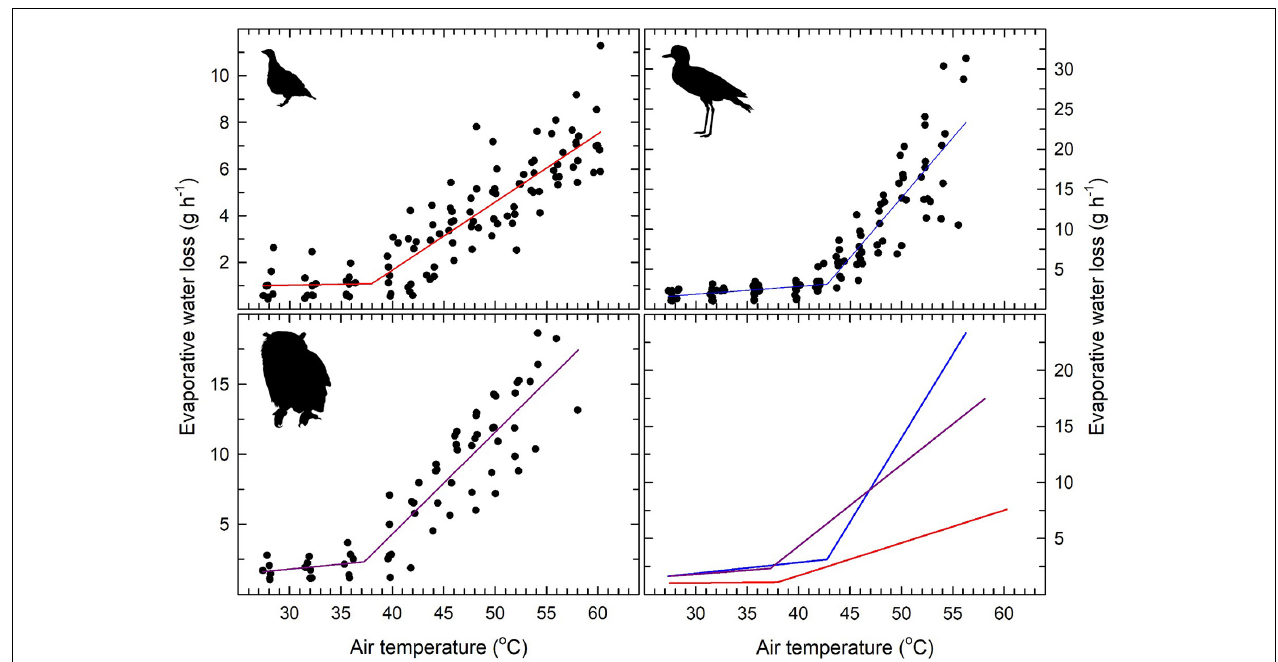
FIGURE 3 | In three medium- to large-sized species from the southern African arid zone, Namaqua sandgrouse ( Pterocles namaqua ; top left), spotted thick-knees ( Burhinus capensis ; top right) and spotted eagle-owls ( Bubo africanus ; lower left), relationships between air temperature ( T air ) and evaporative water loss (EWL) were characterised by significant inflections between T air = 37–43 ◦ C. Above these inflections, EWL increased linearly to maximum values equivalent to 7.4, 12.9 and 7.8 X minimum thermoneutral values in Namaqua sandgrouse, thick-knees and eagle-owls, respectively. The solid lines show segmented linear regression models fitted to each data set, with inflection T air values and slopes for relationships between EWL and T air provided in Table 2 . The lower right panel shows the regression models for all three species plotted on the same axes for comparative purposes. Sources of the bird silhouettes are provided in the Figure 1 legend.